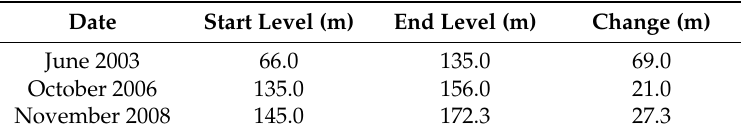
Table 2. Three major impoundments of the TGD between 2003 and